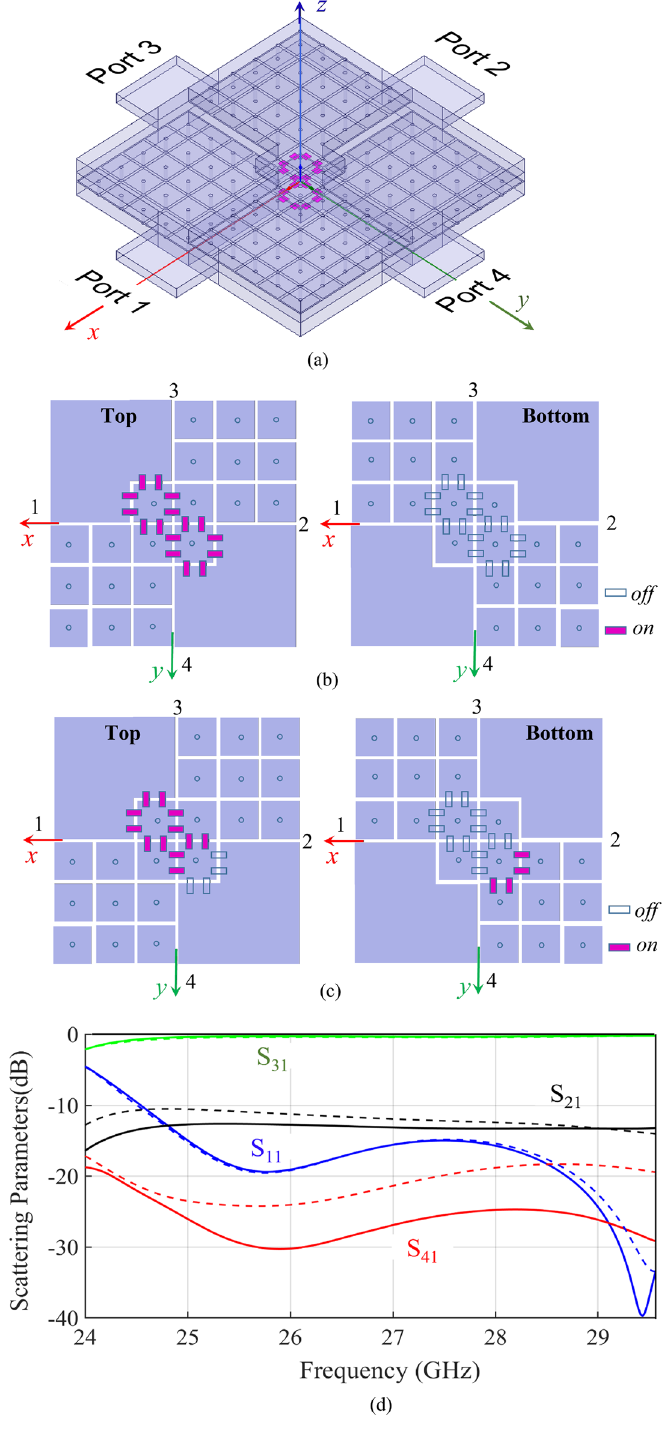
Figure 6. ( a ) Switchable coupler realized by using 2x2 mushroom unit cells in the central part both on the top and the bottom walls; ( b ), ( c ) two different configurations of the pin-diodes ( d ) Simulated Scattering parameters obtained by using HFSS 30 for the two configurations: ( b ) solid lines ( c ) dotted lines.The full wave analysis includes the waveguide ports, as shown in ( a